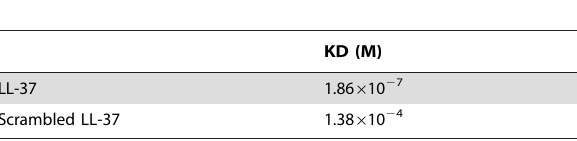
Table 1. Dissociation constants of LL-37 bound to immobilized G-actin using the BIACORE 3000